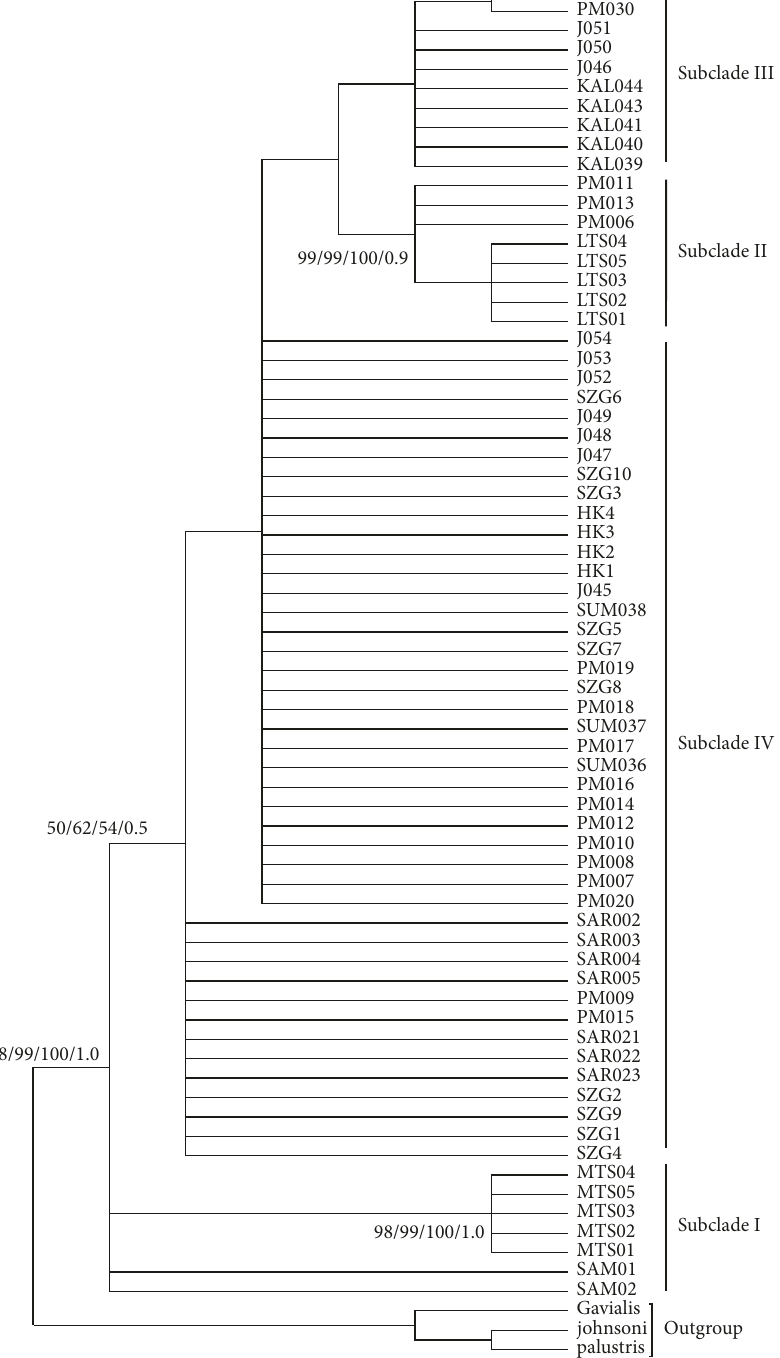
Figure 2: Maximum parsimony of the 50% majority rule consensus tree of mtDNA Cyt b-CR gene sequence of T. schlegelii . Bootstrap values and Bayesian posterior probabilities (BPP) are accordingly indicated below the branch